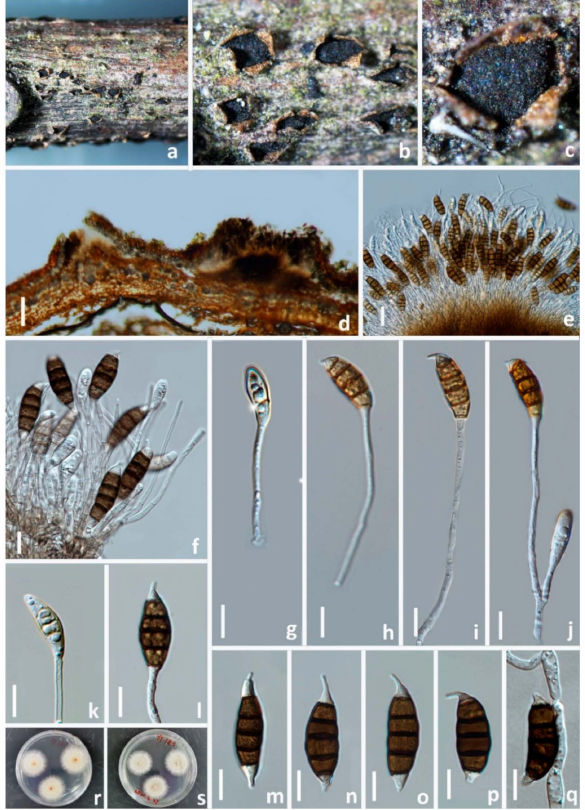
Figure 16. Seiridium vernicola (HKAS 123221, holotype). ( a – c ) Appearance of conidiomata on the host. ( d ) vertical section of conidiomata. ( e , f ) Sporodochia. ( g – j ) Conidiophores and conidia. ( k , l ) Conidiogenous cells and conidia. ( m – p ) Conidia. ( q ) Germinating conidium. ( r , s ) Upper and reverse view of the colony on PDA. Scale bars: ( d ) = 100 µ m, ( e ) = 20 µ m, ( f–q ) = 10 µ